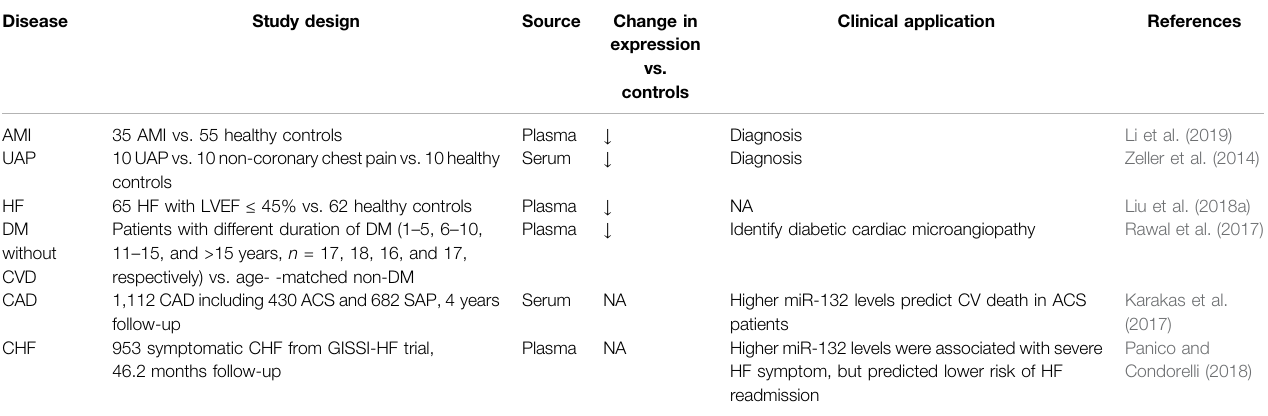
TABLE 1 | Circulating miR-132 as potential diagnostic and prognostic biomarkers in cardiovascular disease.